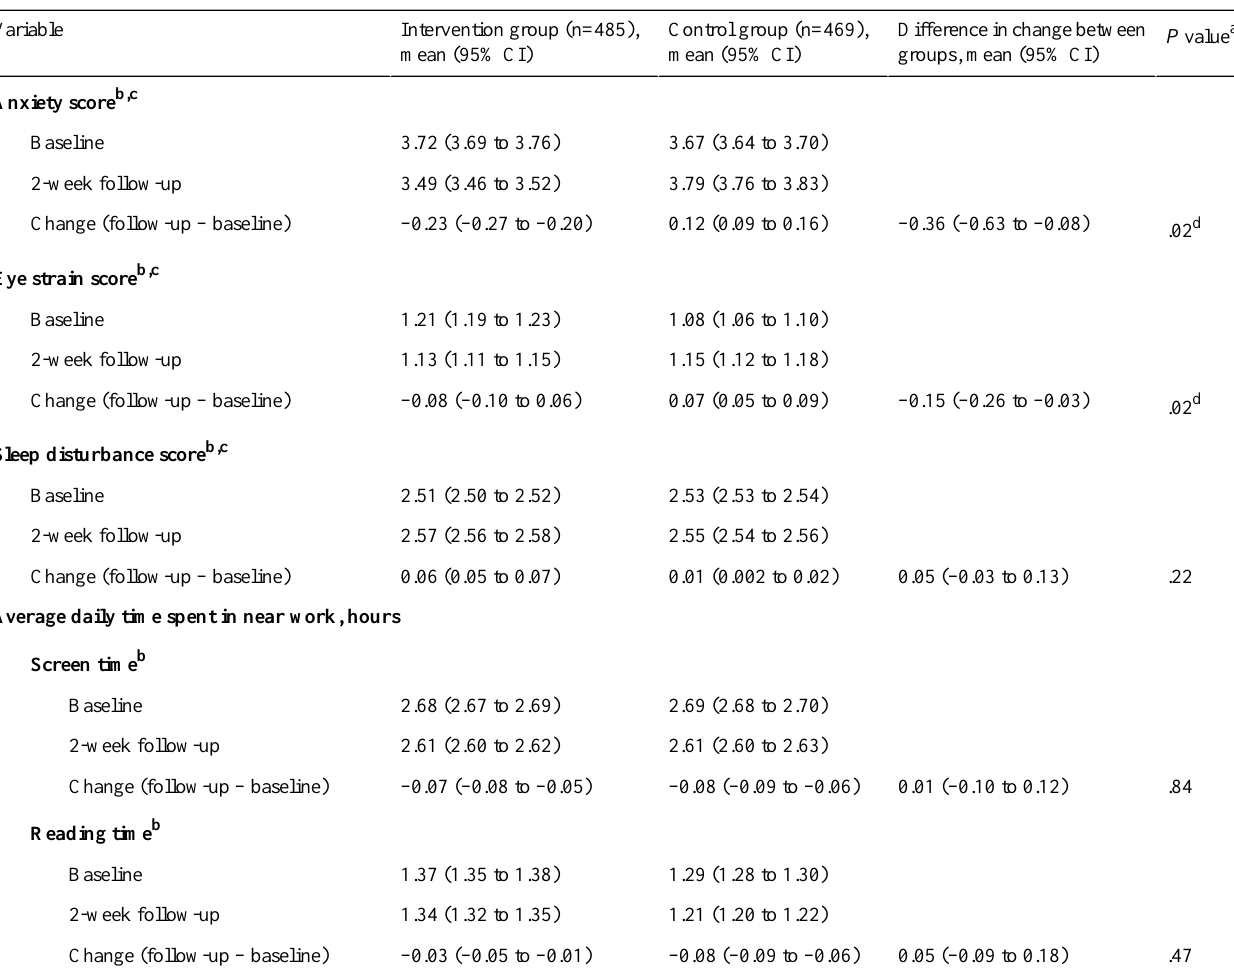
Table 1. Comparisons of change between study groups in self-reported anxiety, eye strain, sleep score, and time spent on different near-work activities between baseline and the 2-week follow-up (intention-to-treat